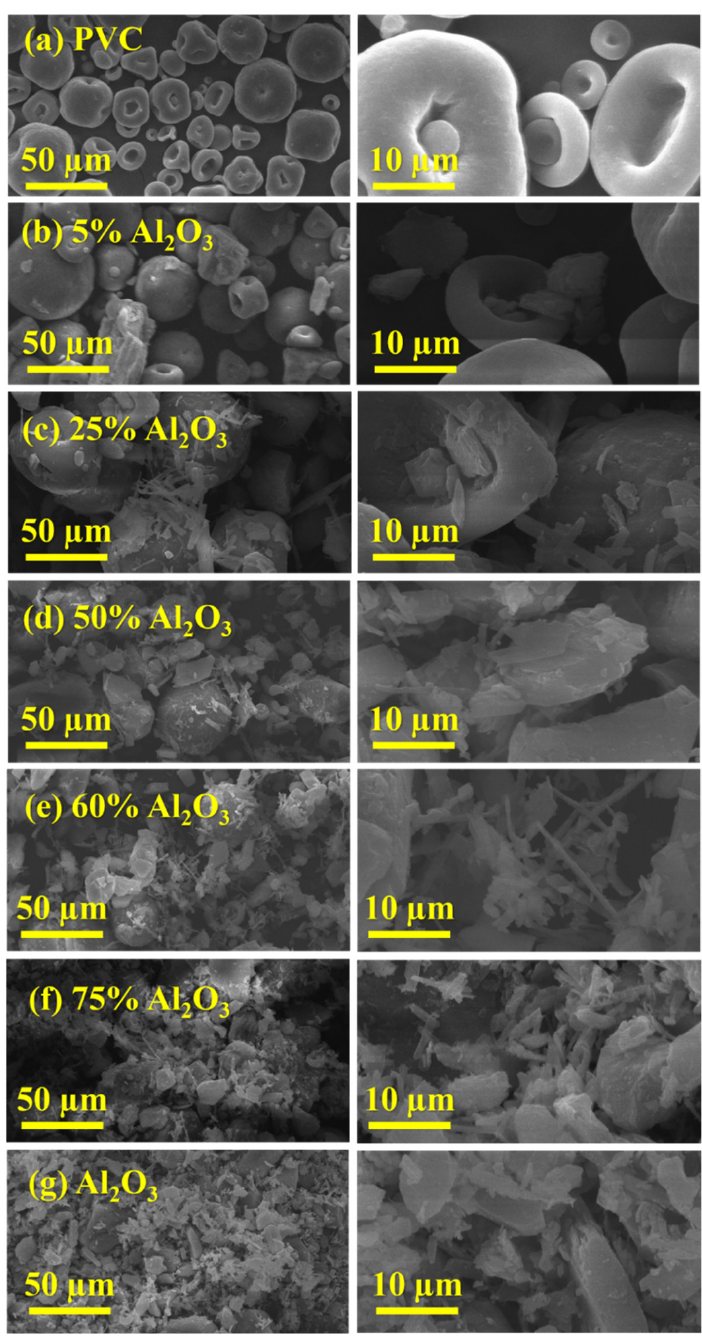
Figure 5. SEM micrograph at different magnifications of ( a ) pure Al 2 O 3 , ( g ) PVC, and ( b − f ) Al 2 O 3 /PVC samples containing different aluminum trioxide amounts.